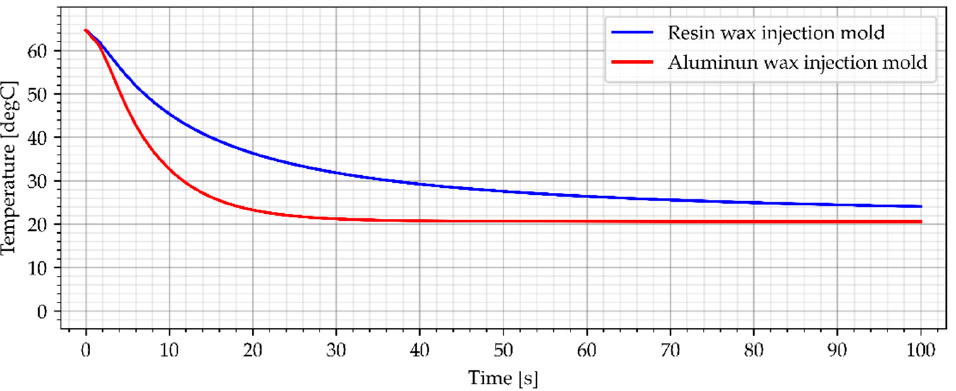
Figure 14. The sample temperature for wax injection molds without cooling channels (middle point).